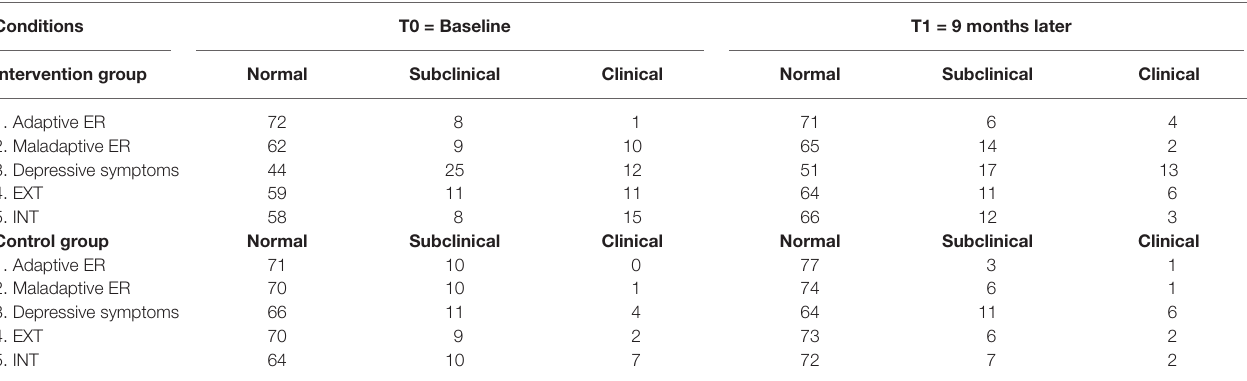
TABLE 2 | The number ( n =) of children in the normal, subclinical, or clinical range at T0 and T1. Conditions T0 = Baseline Intervention group